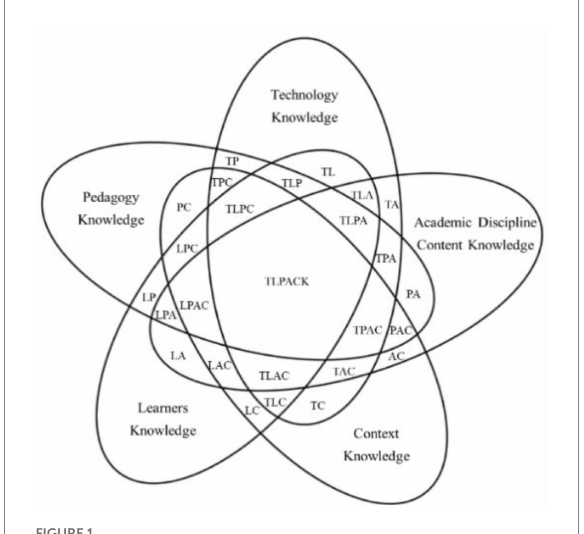
FIGURE 1 The TLPACK model (Hsu and Chen,